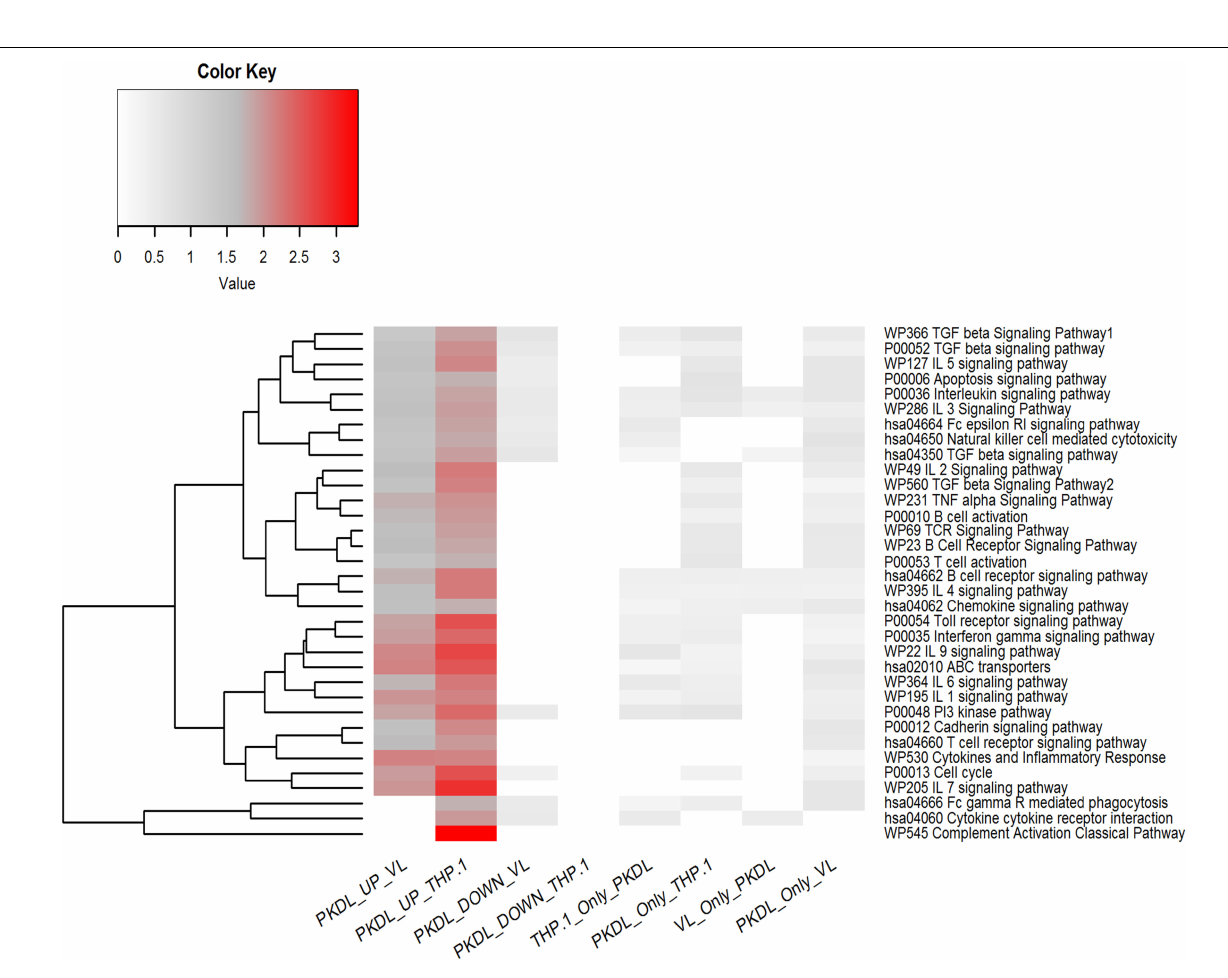
FIGURE 7 | Pathway enrichment test for differentially expressed microRNAs (miRNAs) (up- and downregulated in G PKDL with respect to G THP and G VL ) and unique miRNAs of G THP , G VL , and G PKDL . Horizontal lanes are marked with selected immunological pathways, and vertical lanes are marked with comparison groups. The enrichment analysis [false discovery rate (FDR) corrected P < 0.05] for each comparison groups are performed separately with reference set being all expressed miRNAs of the corresponding comparison